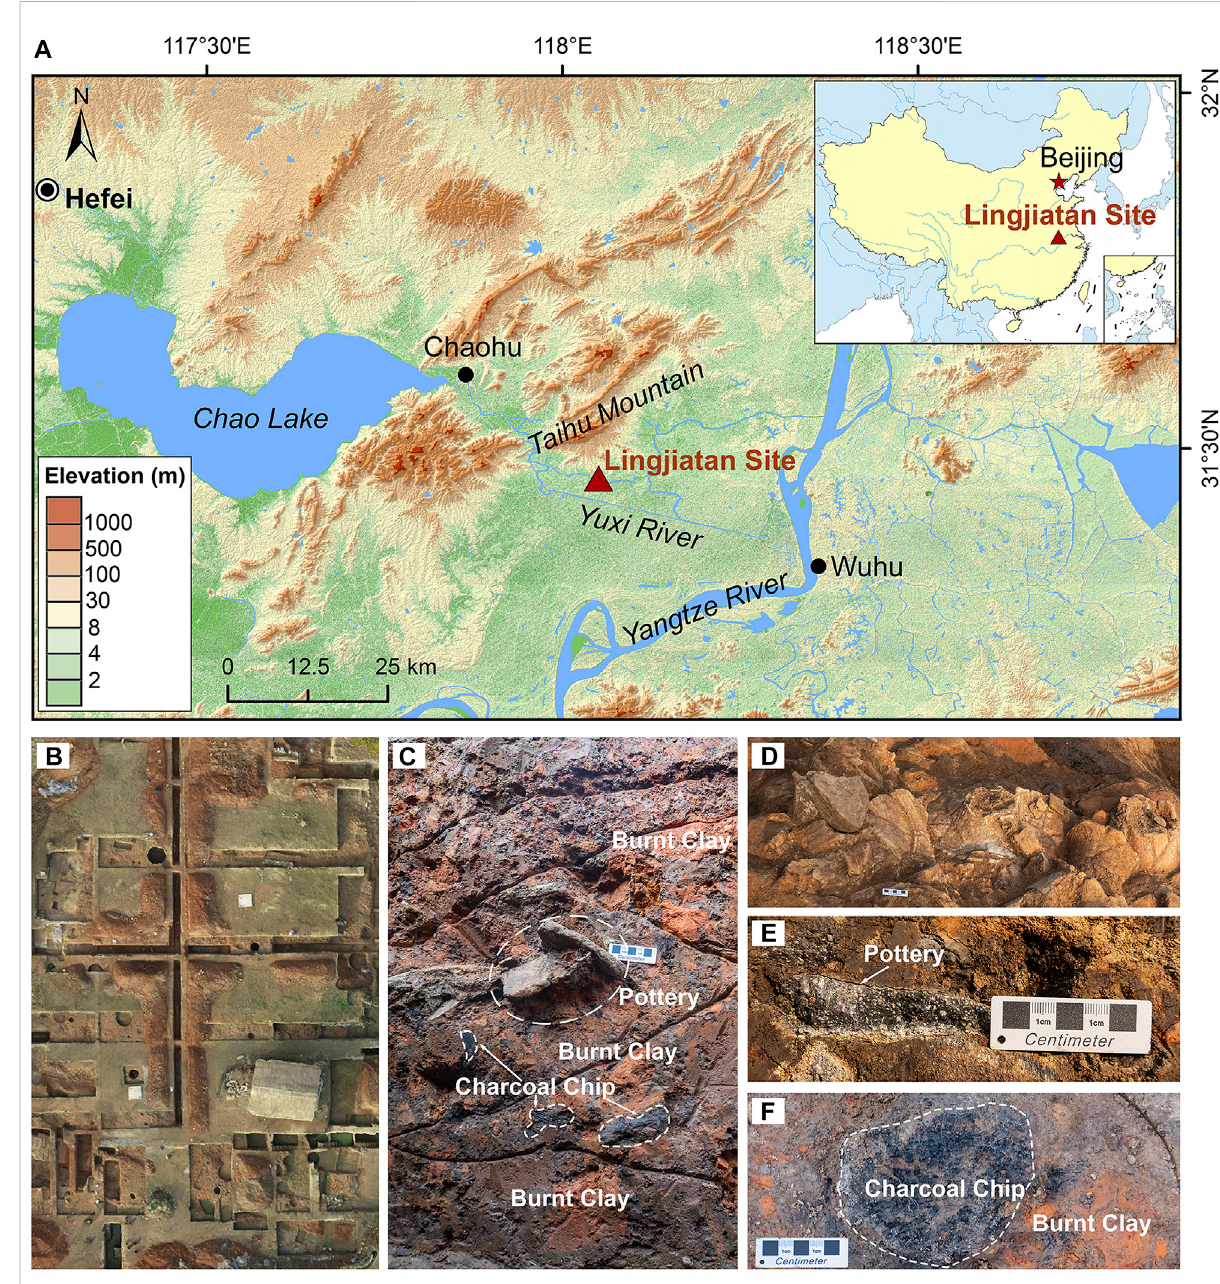
FIGURE 1 (A) The location of the Lingjiatan archaeological site. (B) Aerial view of the site excavation. (C) The picture shows the red burnt clay pro fi le with the pottery shards collected for dating buried in the burnt clay. The black material mixed in burnt clay is burnt charcoal chips collected